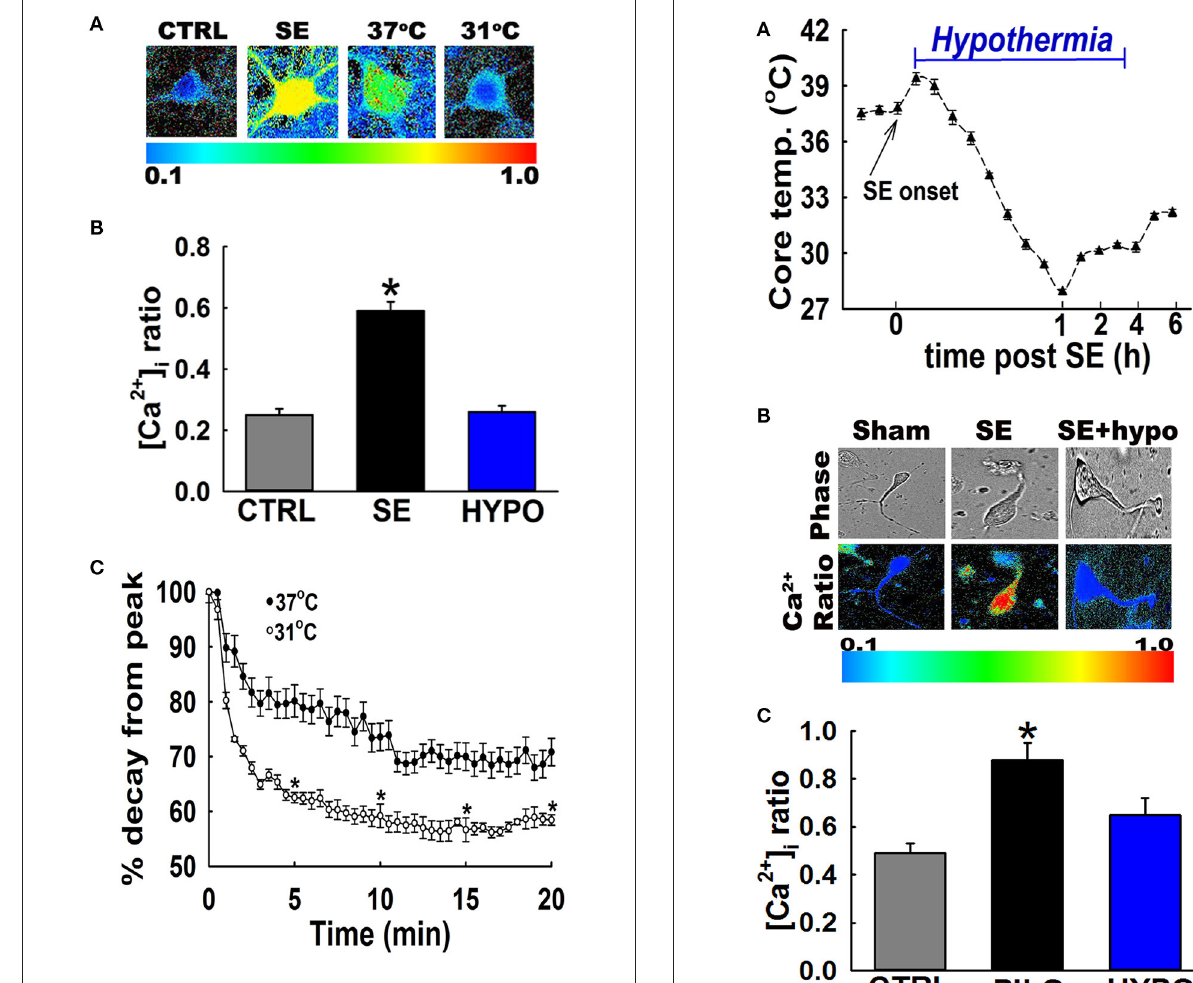
FIGURE 2 | Hypothermia blocked the Ca 2 + plateau after in vitro SE. (A) Pseudocolor ratiometric images of representative hippocampal neurons in culture from control, low Mg 2 + SE, 37 ◦ C pBRS, and 31 ◦ C pBRS. All the ratiometric images are at the 20-min time point following respective treatments. (B) Fura-2 340/380 ratiometric values at the end of 20-min of treatment with hypothermic solution (31 ◦ C pBRS). (C) Ca 2 + decay curves in the presence and absence of hypothermic intervention. Following 3h of in vitro SE (time = 0), cells were washed with either 31 ◦ C pBRS or 37 ◦ C pBRS.